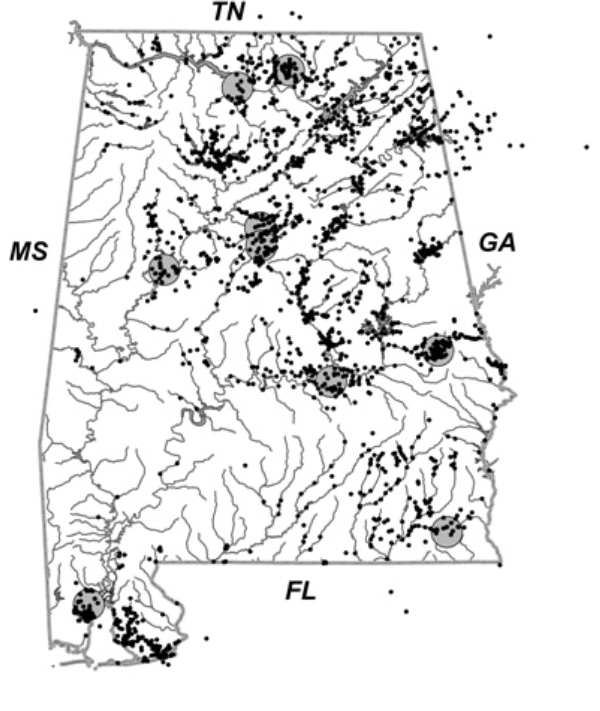
Fig. 1 . Map of Alabama showing major streams and reservoirs, 9 urban centers with at least 50,000 people (large grey dots;